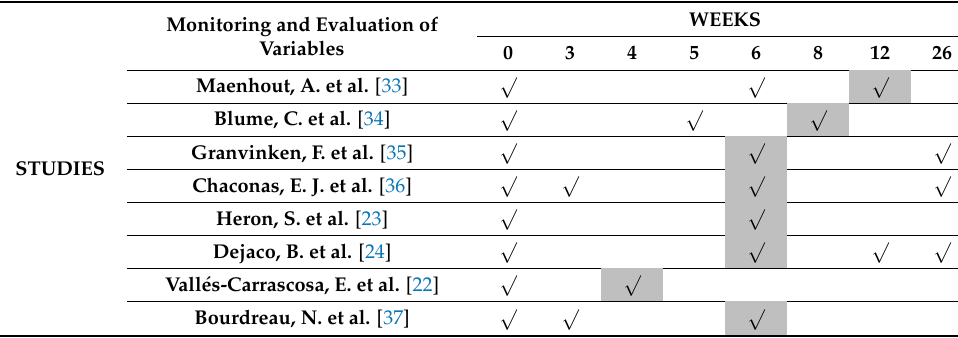
Table 5. Duration and monitoring of the intervention.